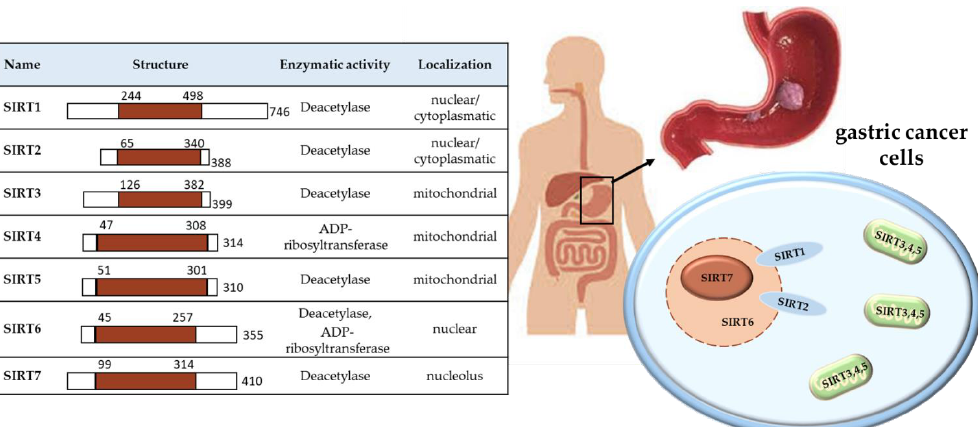
Figure 1. C haracteristics of the SIRTs location and role in the